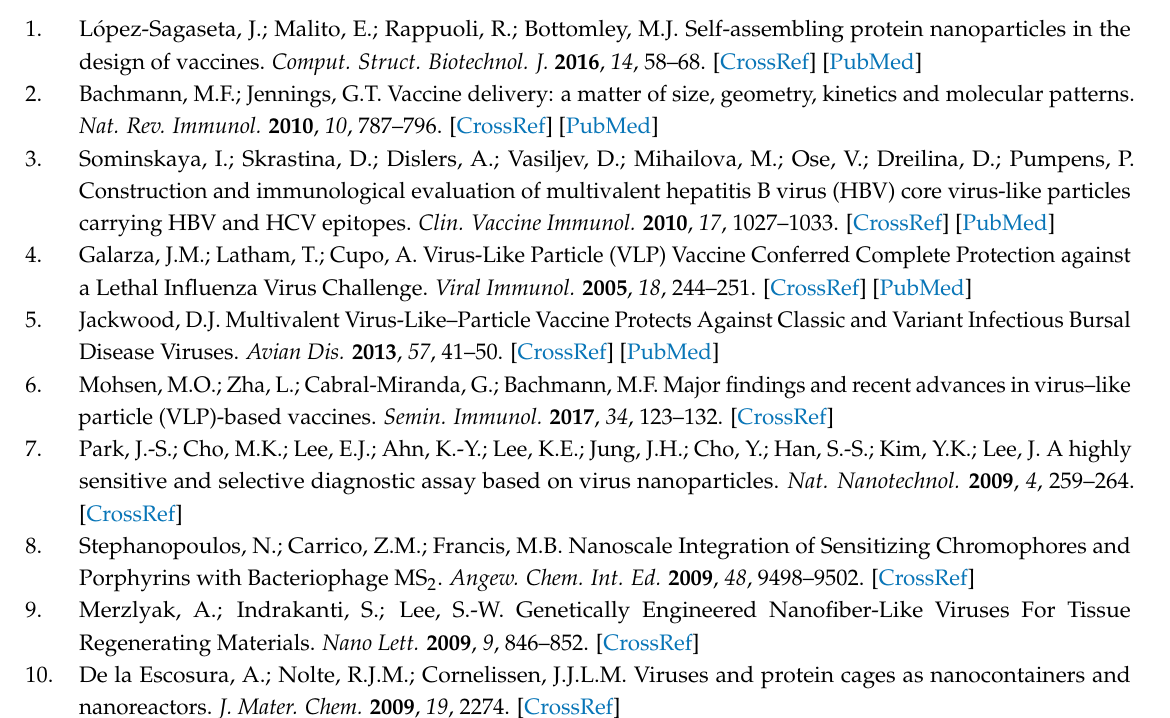
Figure S1: TEM images of as synthesized SPIONs, Figure S2: DLS results for SPION-PEG and SPION-DHP, Figure S3: ζ -potential for SPION-DHP and SPION-PEG, Figure S4: ELISA of HBcAg SPION